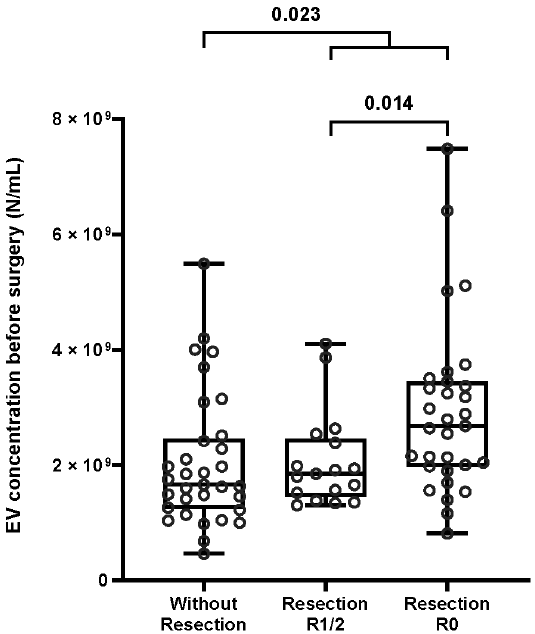
Figure 2. Box plot representing sEV concentrations before surgery in different subgroups of patients. Patients with resection had significantly higher concentrations of sEV than patients without resection ( p = 0.023). Patients with R0 resection had significantly higher concentrations of sEV than patients with R1/R2 resection ( p =